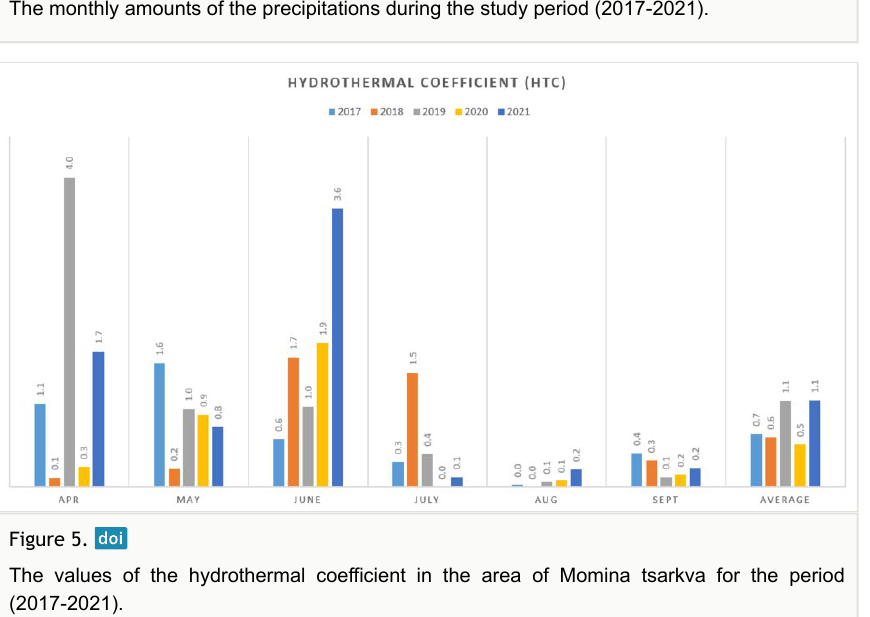
The values of the hydrothermal coefficient in the area of Momina tsarkva for the period